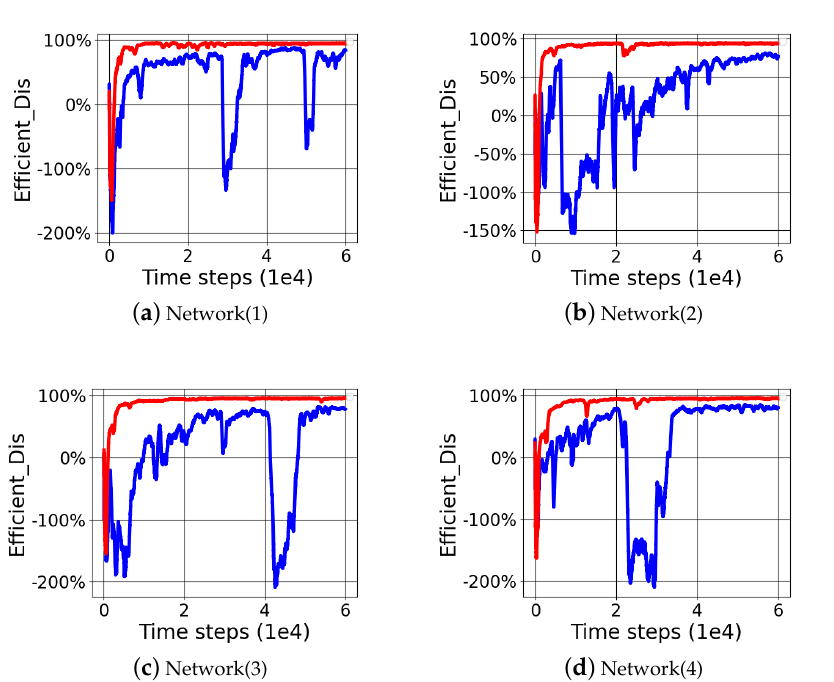
Figure 8. Under the reward function (2), the efficient distances between RTD3 (red) and TD3 (blue) for four times of randomly initialized network node parameters under the same initial network node conditions as shown above in ( a – d ).